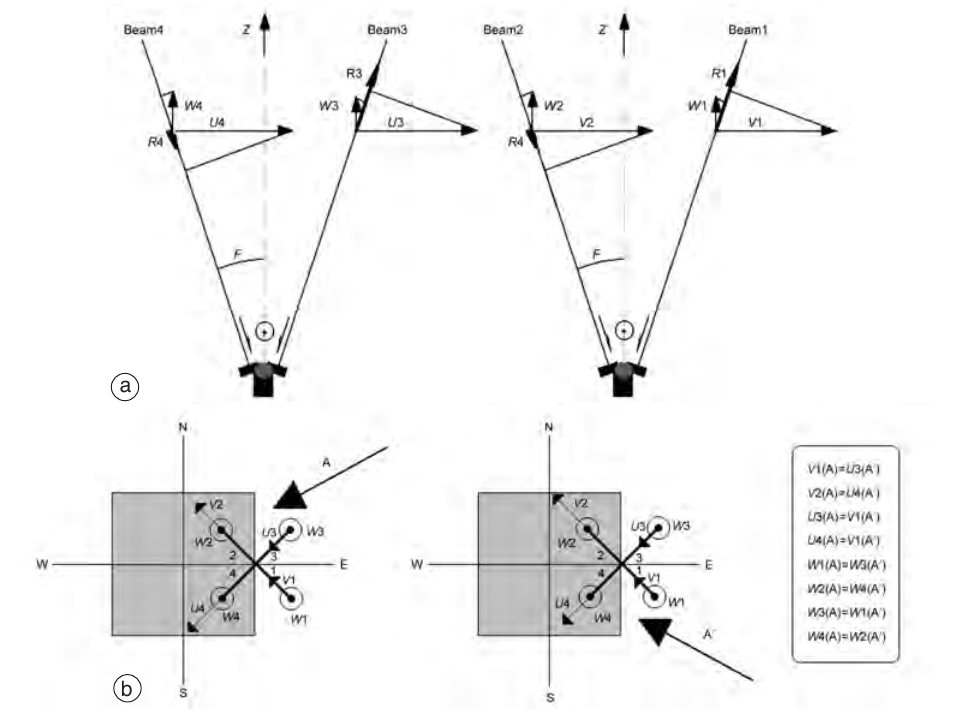
Fig. 11a,b. a) Beams and current components configuration in case of an heterogeneous current field; b) hori- zontal components of currents towards directions A and A l symmetrical with respect to east-west, and compo- nents correspondence.